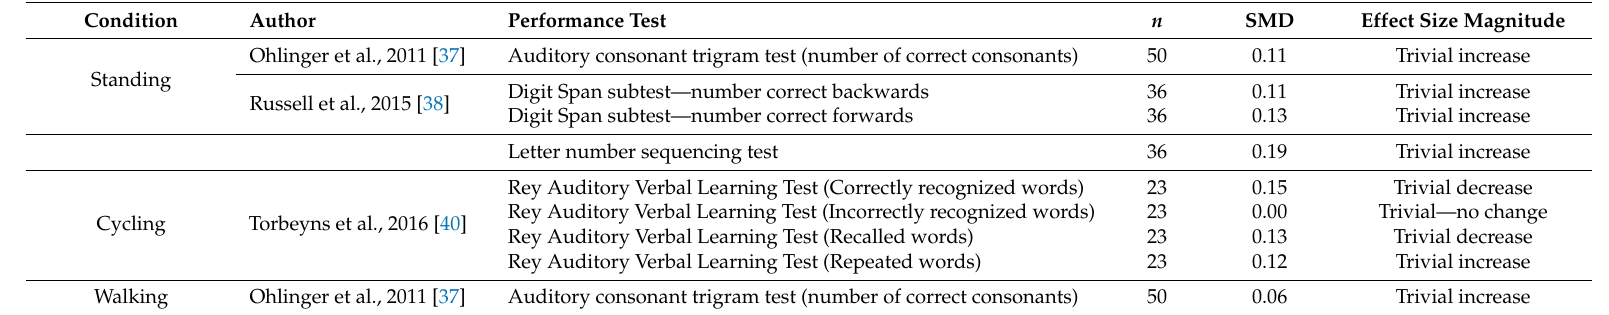
Table 4. Effect of active workstation use on